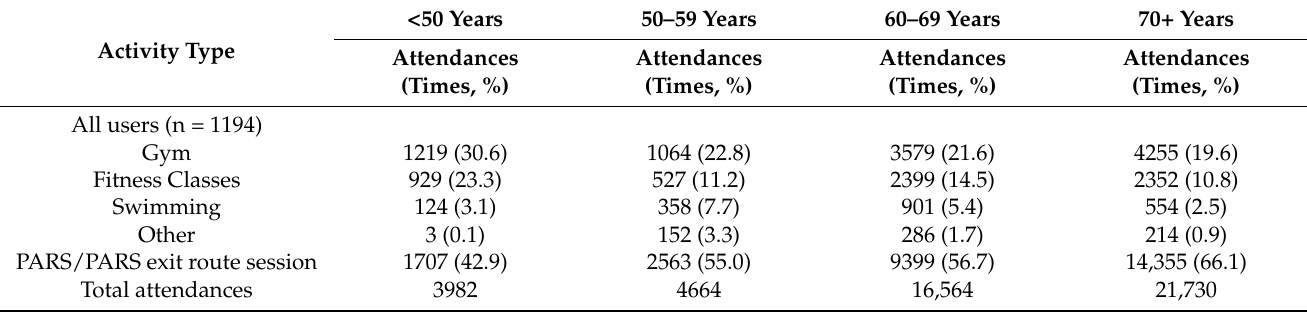
Table 4. Attendance and activity choices by age